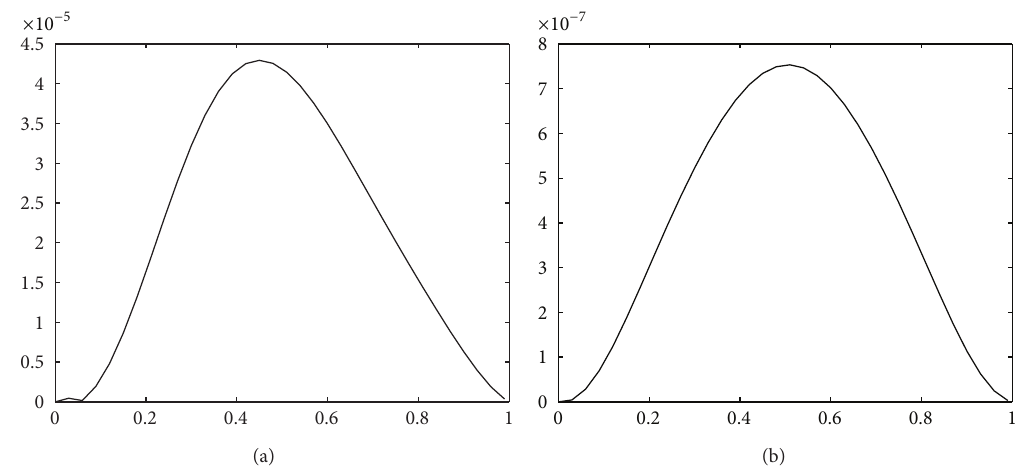
Figure 2: Error function of problem (63) for 𝑚 = 4 (a) and for 𝑚 = 7